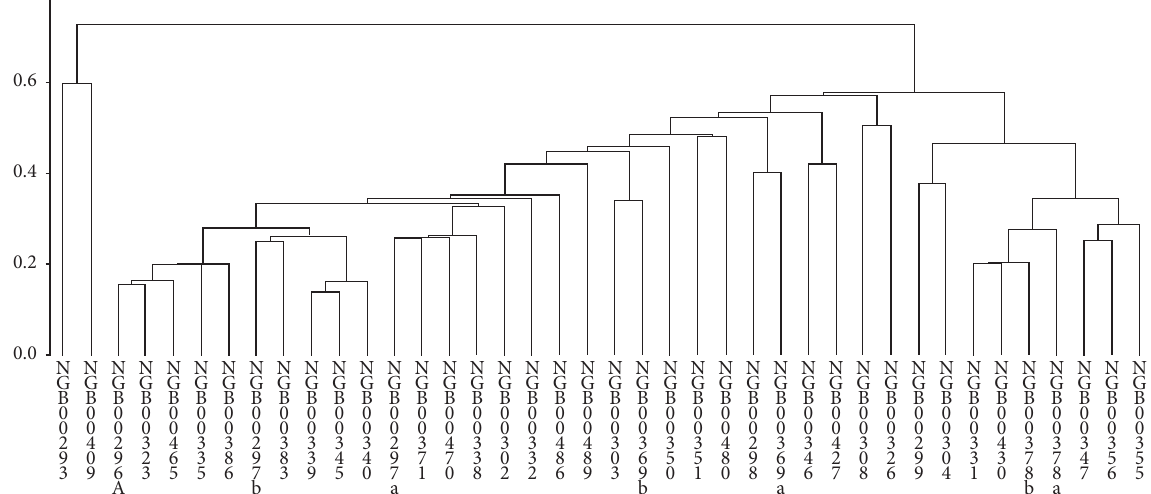
Figure 9: A dendrogram showing the genetic relationship among forty genotypes of okra based on quantitative traits using single-linkage cluster